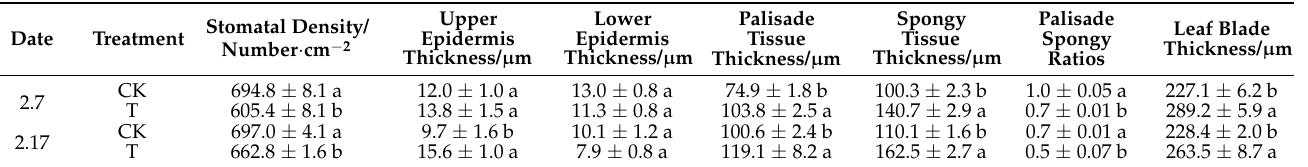
Table 3. The effect of enhanced UV-B radiation on the microstructure of mesophyll cells in leaves.